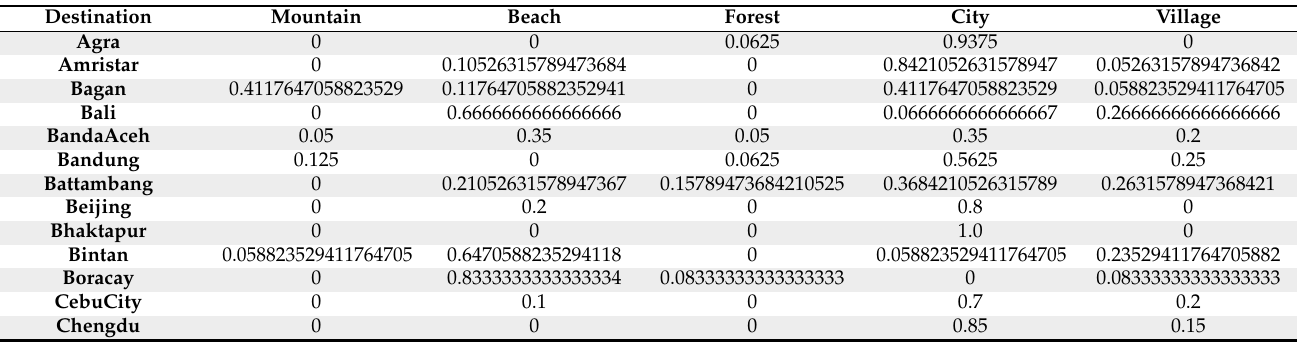
Table 4. Prediction of destination categories using CNN Model.